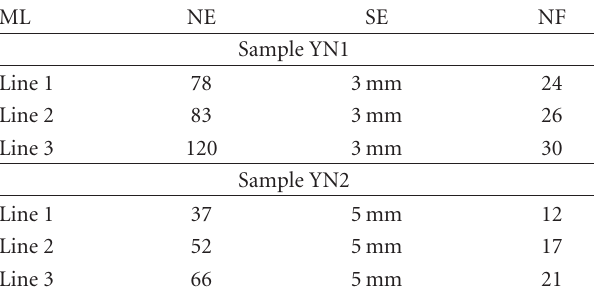
Table 2: Parameters of measuring